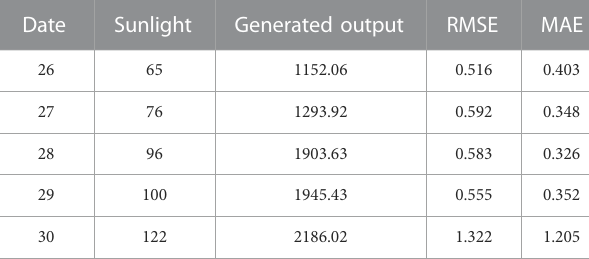
Figure 6 lists the fi nal power predictions of different network